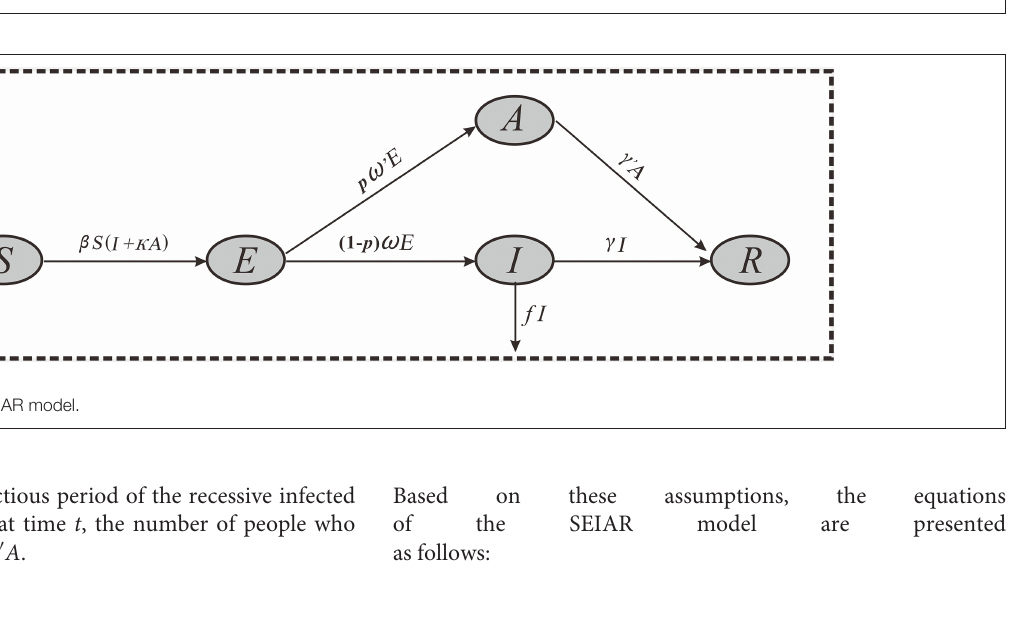
FIGURE 1 | Study design for analyzing the differences of capability to control COVID-19 among 160 countries.